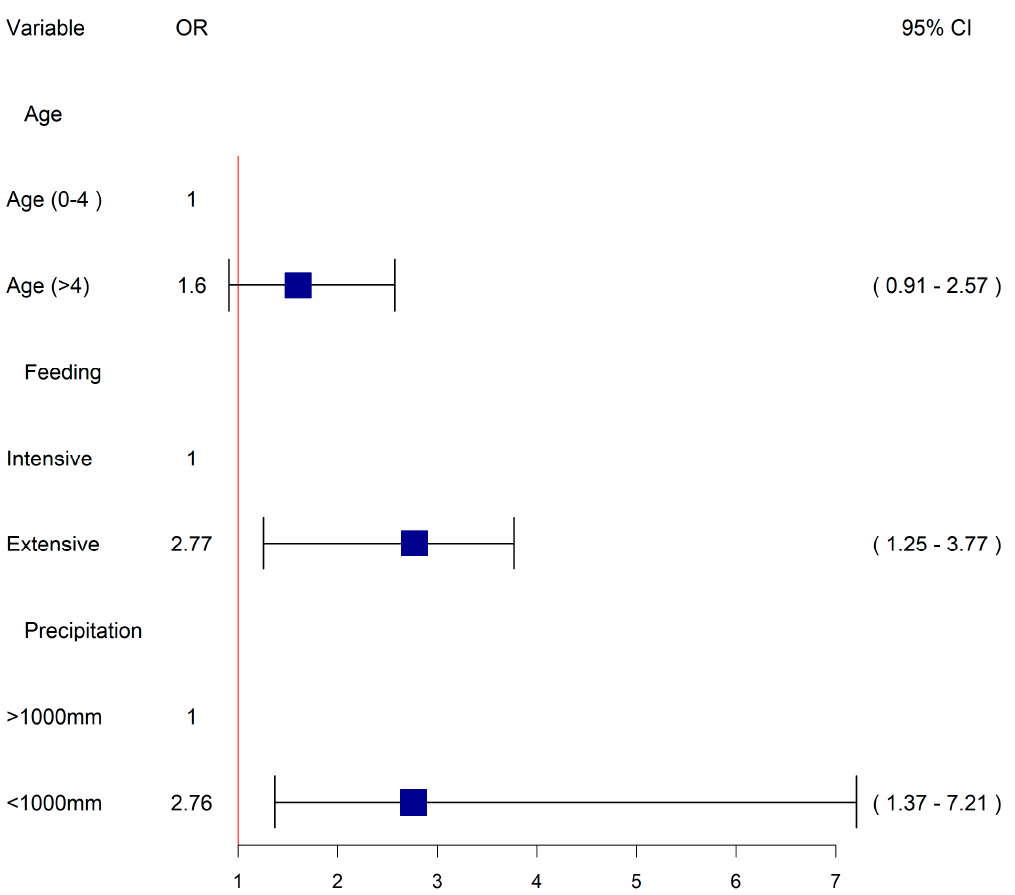
Figure 5. Forest plot showing the final multivariable logistic model. For each category the variables, levels, odds ratios (OR) with 95% confidence interval (95% CI), are provided. Horizontal lines in black and boxes in dark blue colors are, respectively, depicting the 95% confidence intervals and odds ratio of each variable. Precipitation data is measured as average annually.